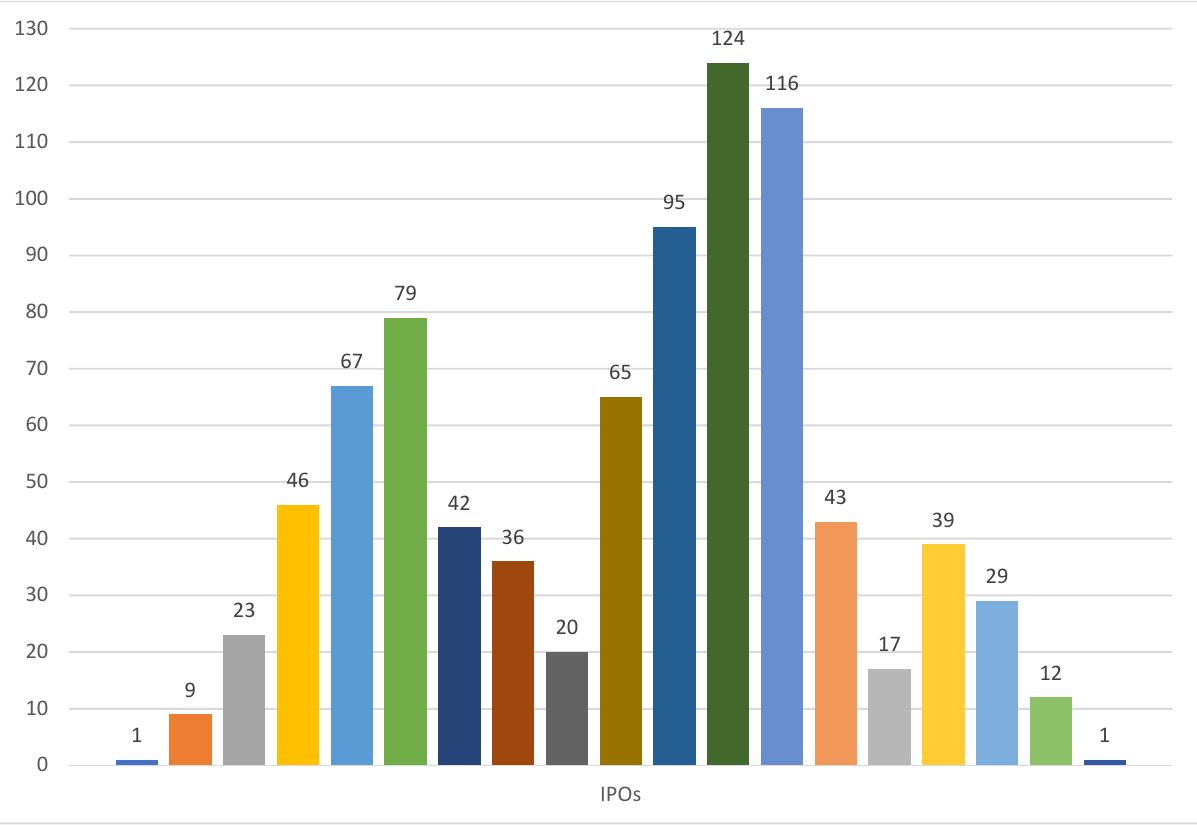
Figure 1. Initial public offerings by year (1995–2013). Source: Own elaboration.